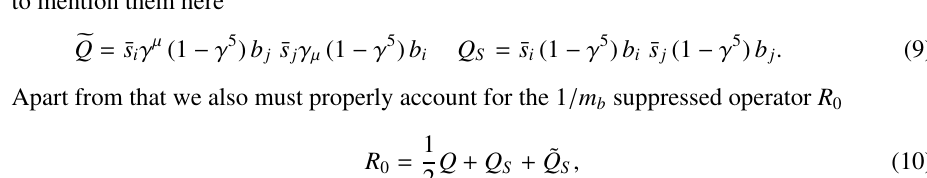
∆ B = 1 and ∆ B = 2 diagrams entering the b ¯ s | | | | ∆ B = 1 contributions from Q 2 ⇥ Q 8 (2 loops) and Q 1 ⇥ Q 2 (3 loops), while (c) | | ∆ B = 2 operators ˜ Q s and Q | |